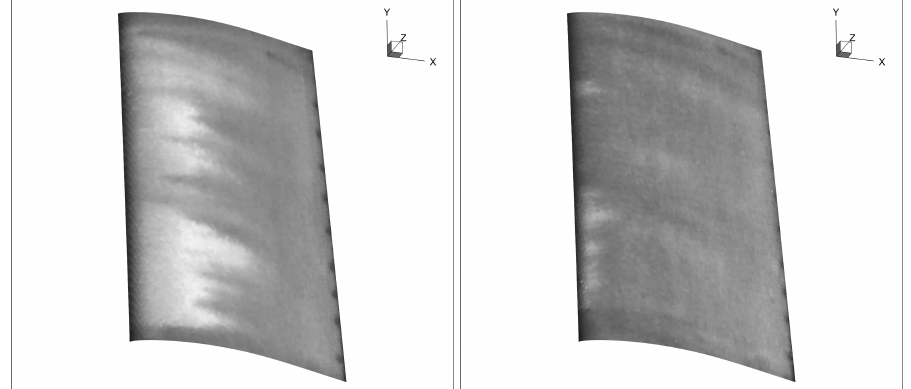
Figure 18. Thermal images from Figure 17 after reconstruction and mapping onto the 3D grid of the aerodynamic glove. Images are from 11:22:27 ( Left ) and 11:23:13 ( Right ), both SCADA time. Here, only the glove is